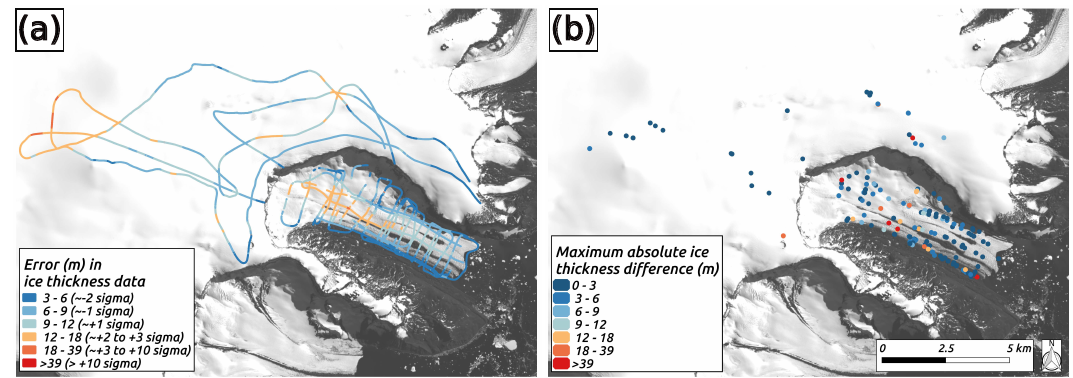
Figure 6. ( a ) Summed data error (cid:101) HData in ice thickness data for 2018. The values in the brackets i within the legend describe the deviation from the mean error of ∼ 9m in terms of the standard deviation of ∼ 3m. ( b ) Maximum absolute ice thickness difference at crossing flight paths for 2018. Background image: Landsat-8 (20 February 2017, courtesy of the U.S. Geological Survey).